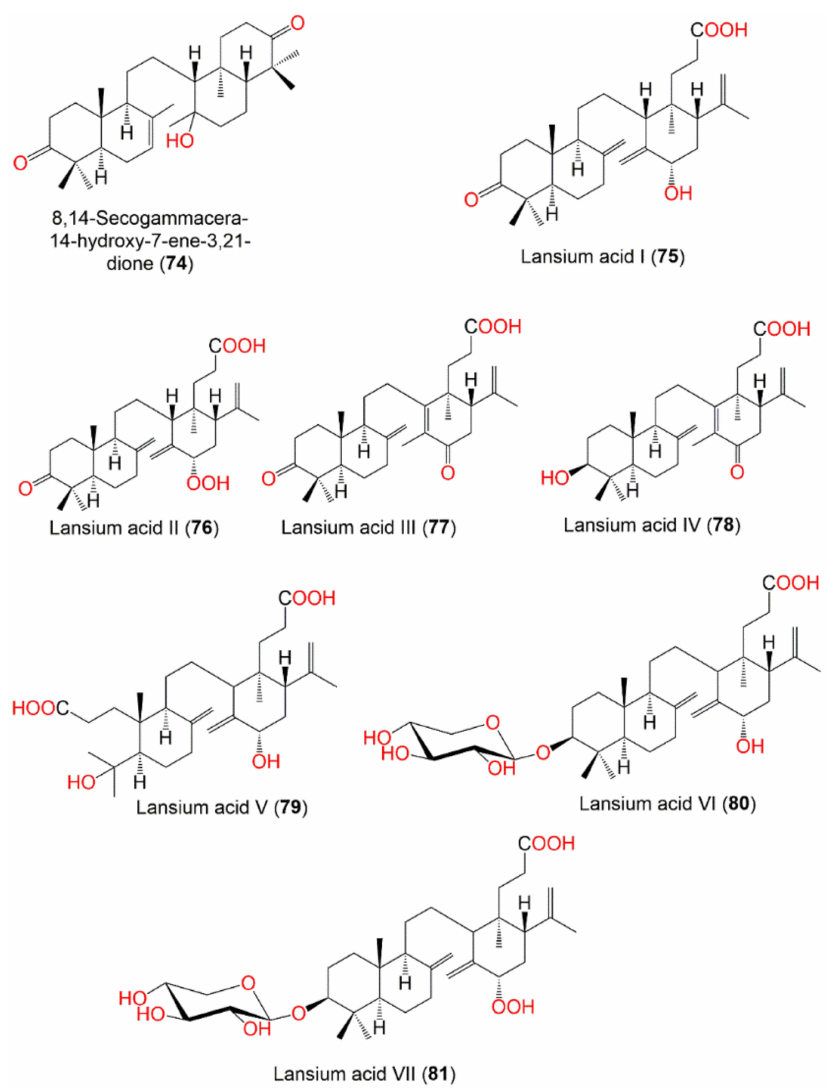
Figure 7. Structures of compounds 74 – 81 from Lansium domesticum . Leatemia et al., stated that the EtOH seed extracts of L. domesticum obtained from different locations and years in Maluku, Indonesia had an insecticidal potential towards Spodoptera litura , with a % growth inhibition of 78–118% with no significant effect